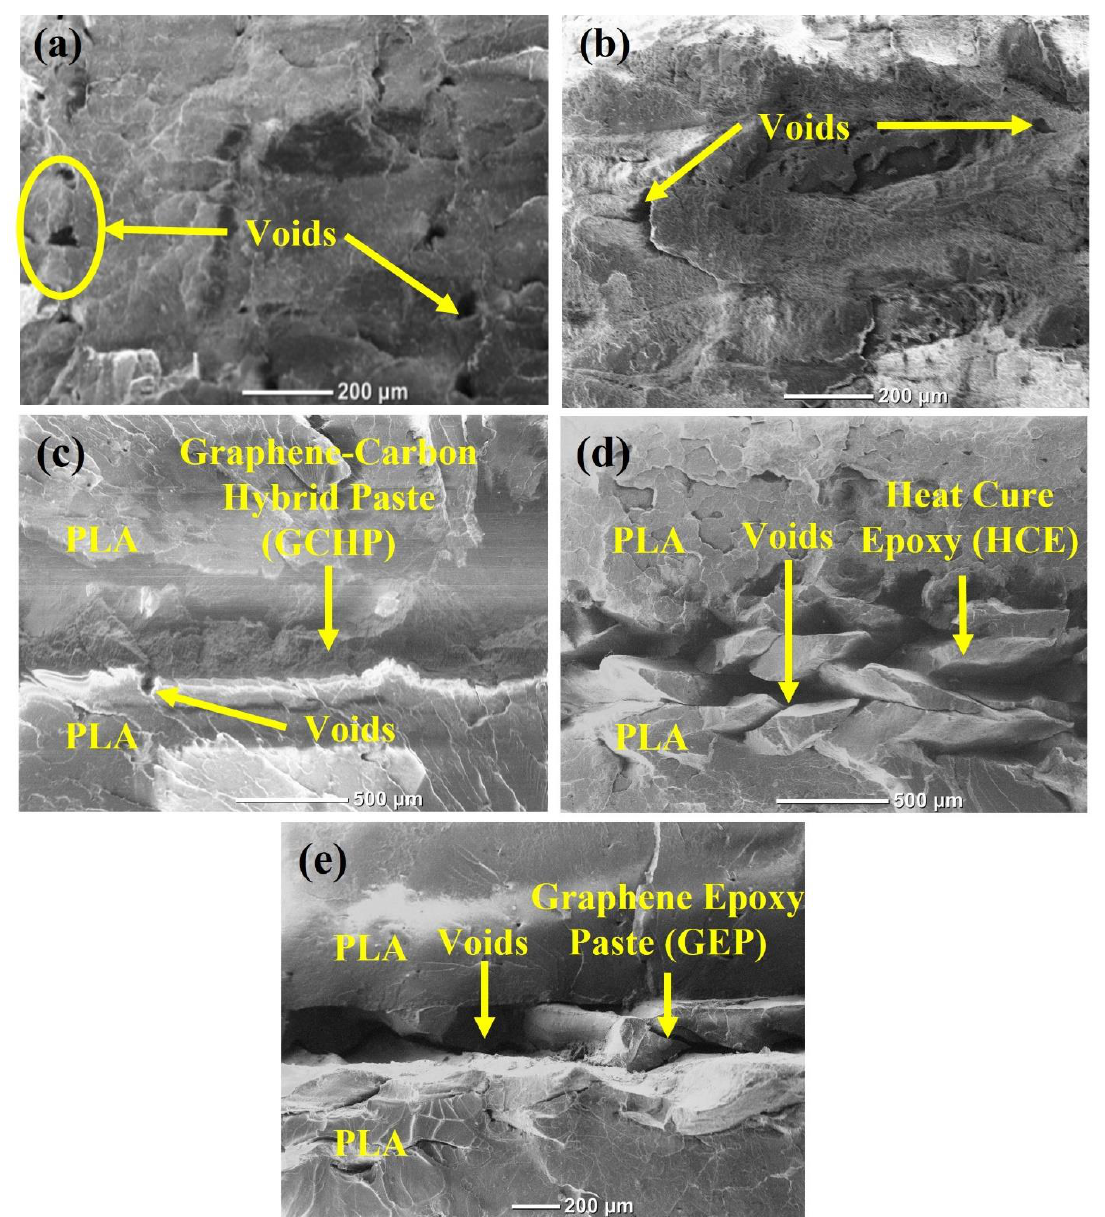
Figure 10. SEM fracture interfaces: ( a ) PLA; ( b ) GPLA; ( c ) PLA/GCHP; ( d ) PLA/HCE; ( e ) PLA/GEP.